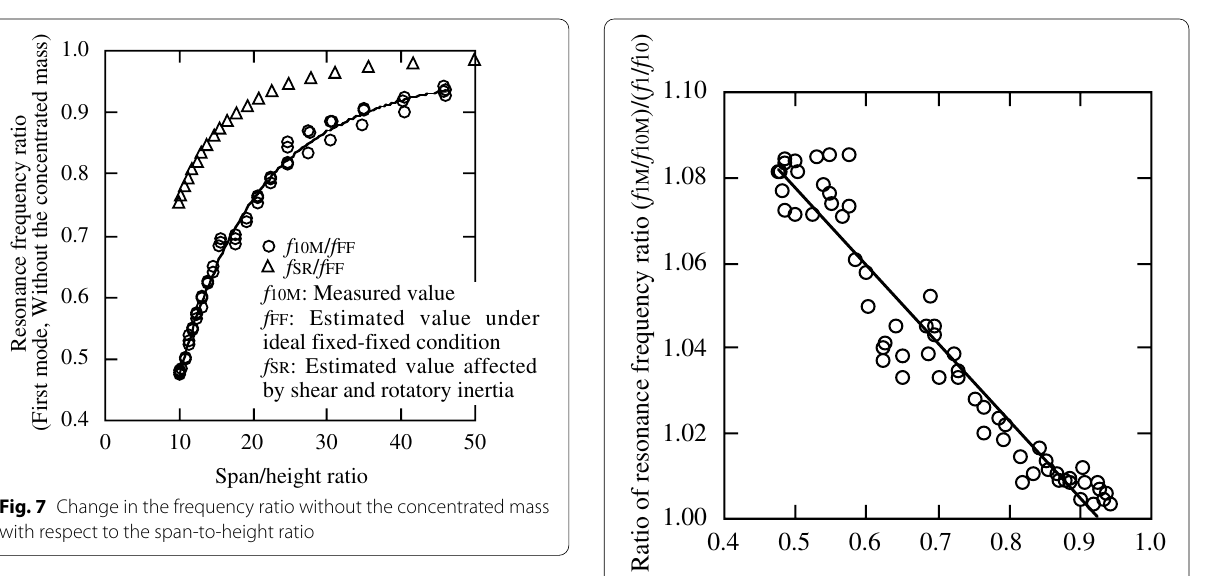
Fig. 7 Change in the frequency ratio without the concentrated mass with respect to the span-to-height ratio From Eqs. (1) and (15),